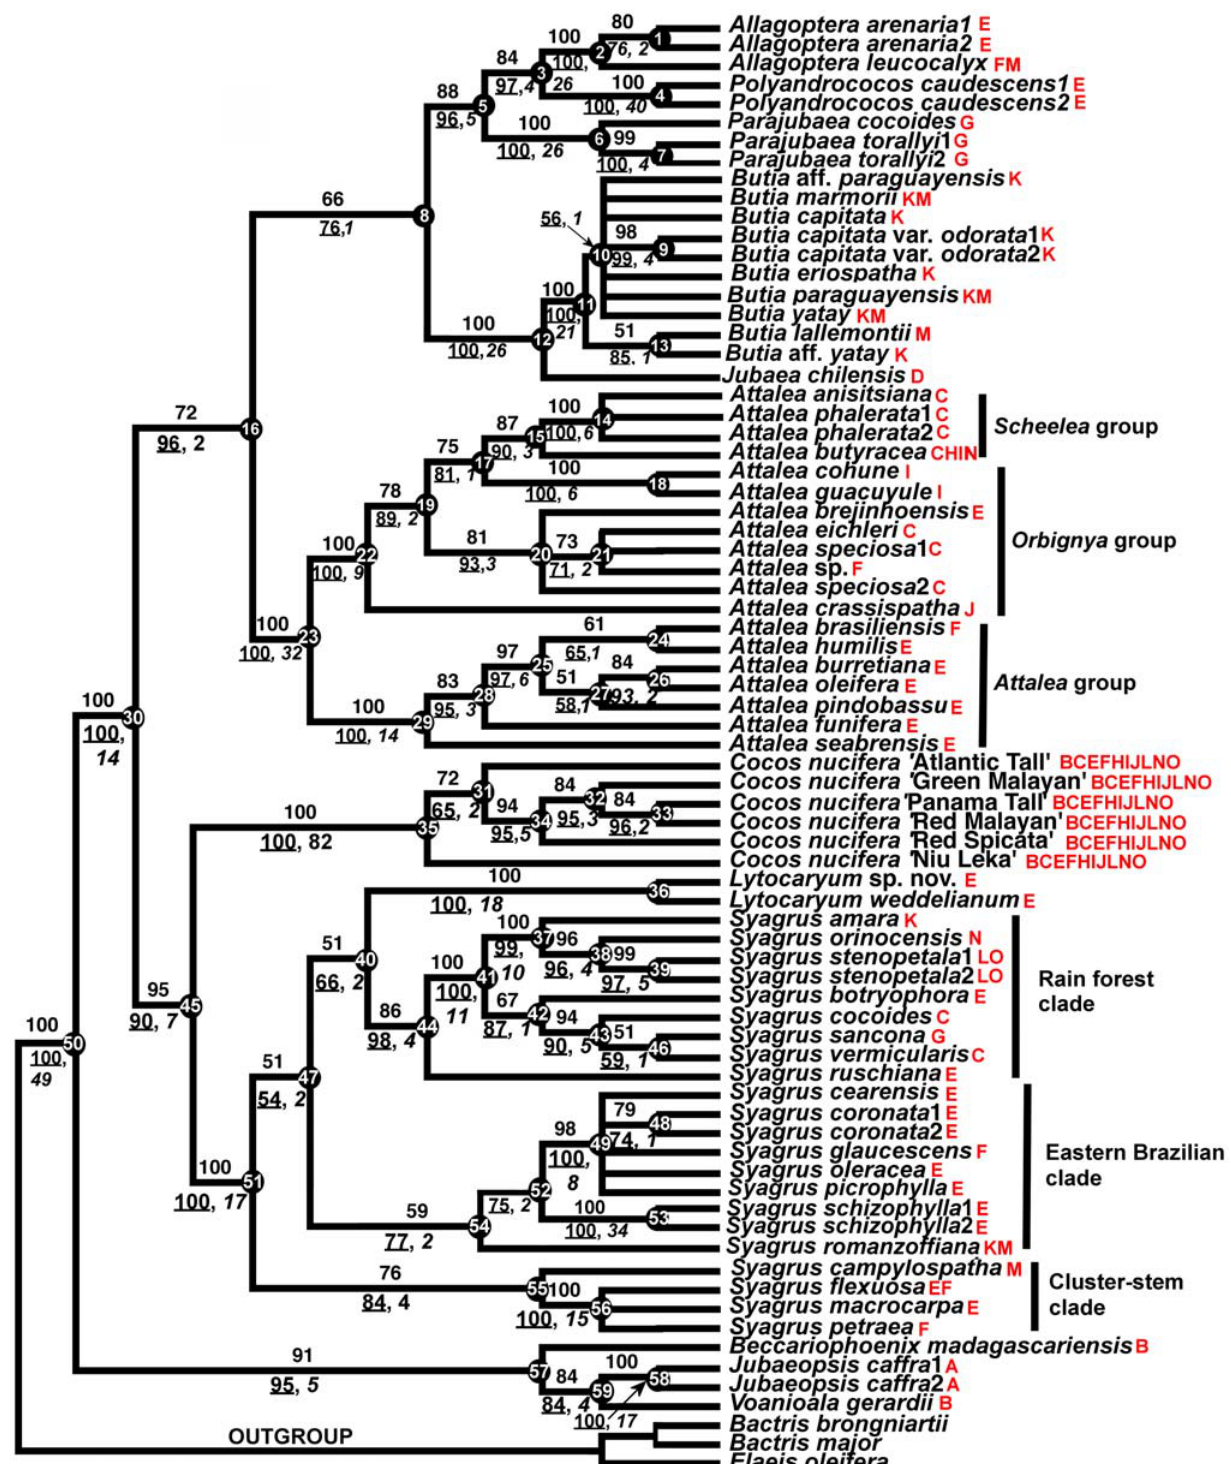
Figure 1. Strict consensus tree of equally parsimonious trees found by heuristic maximum parsimony analysis of seven combined WRKY loci sequences aligned across Areceaceae tribe Cocoseae subtribe Attaleinae. Numbers above branches are bootstrap support percentages. Numbers below branches are ML bootstrap support (underlined) and non-partitioned decay indices (italic). The numbers at each node refer to Table 2, which see for partitioned decay indices. Letter designations in red are area distributions of terminal taxa: A=South Africa, B=Madagascar, C=Amazonas (north, east, south), D=Chile, E=Eastern Brazil, F=Central Brazil, G=Andes, H=Central America, I=Mexico, J=West Indies, K=Southern Brazil, L=Northern South America, i.e., Caribbean coastal Venezuela and Colombia, French Guiana, Guyana, Surinam, M=Argentina-Paraguay-Uruguay, N=Colombia-Venezuela ( llanos region), and O=western Amazonas.